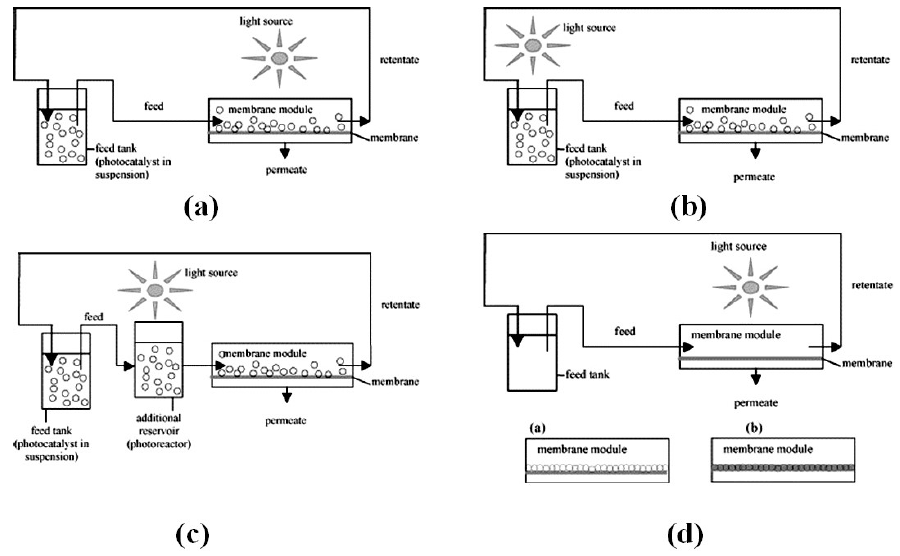
Figure 6. PMR utilizing photocatalyst in suspension with irradiation of the membrane ( a ); irradiation of the feed tank ( b ); irradiation of the additional reservoir (photoreactor) located between the feed tank and membrane module ( c ); and PMR utilizing photocatalyst immobilized on a membrane or within a membrane ( d ) [97]. Reproduced with permission from [97].